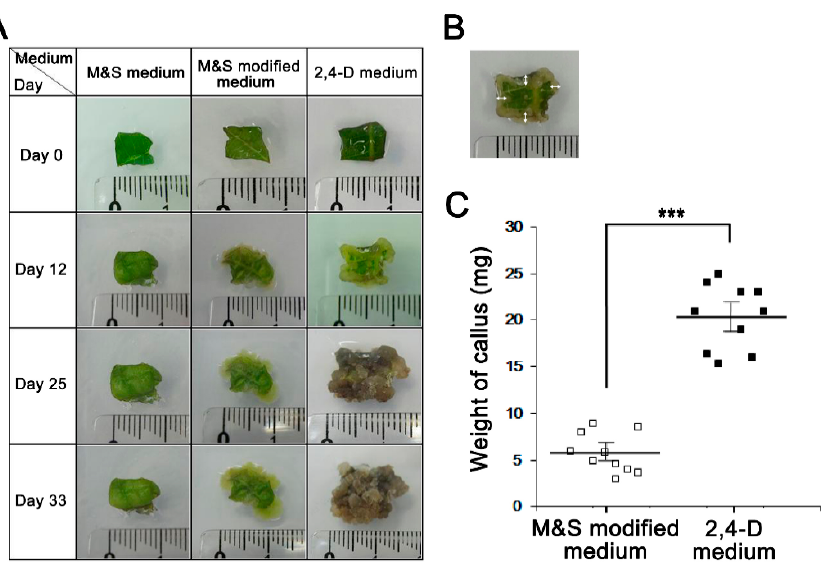
Figure 2. The effect of Perilla callus formation in 2,4-D and two M&S media. ( A ) Perilla callus induction dependence on the three medium types. Representative photographs showing Perilla calluses on culture days 0 to 33. ( B ) Calluses that formed from the four corners of Perilla leaves were measured using a ruler. ( C ) Weights of calluses by medium type. We measured the biomasses of Perilla calluses after culture for 5 weeks. Dots and bars represent the means and SDs of three independent samples. *** p < 0.001 as determined by the t-test.